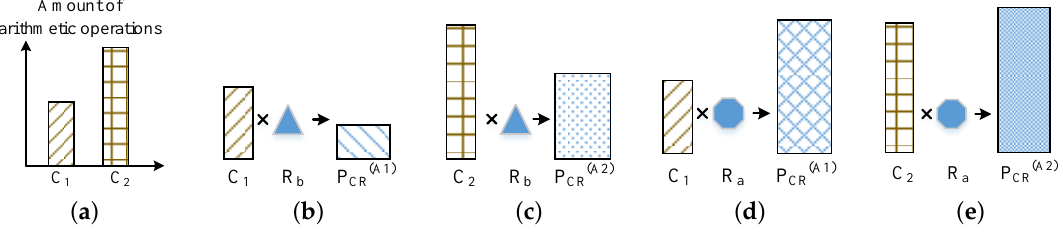
Figure 11. The computation amount and the algorithm-hardware-cost-factor (AHCF) with different R . ( a ) Computation amount of two different algorithms. ( b ) A small algorithm implemented by the operations with less hardware resources. ( c ) A big algorithm implemented by the operations with less hardware resources. ( d ) A small algorithm implemented by the operations with huge hardware resources. ( e ) A big algorithm implemented by the operations with huge hardware